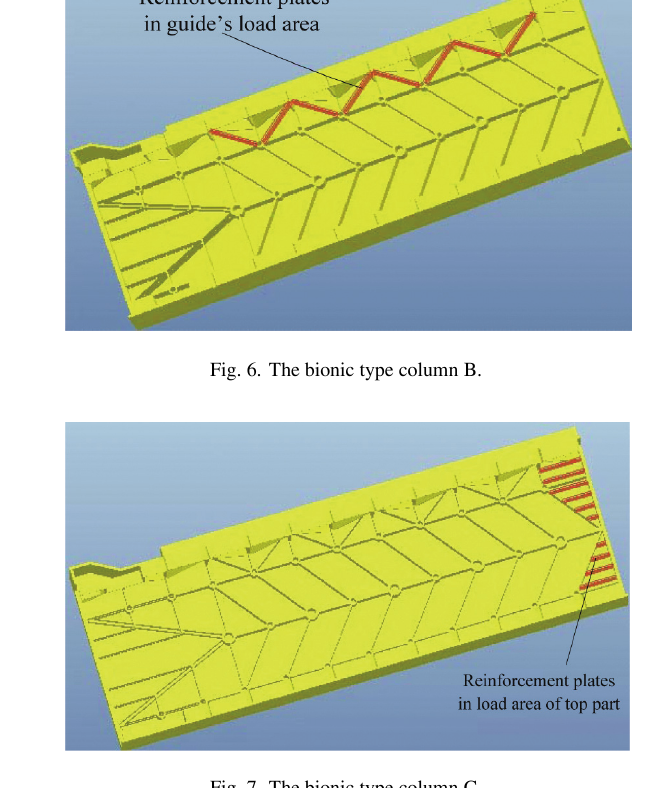
Fig. 7. The bionic type column